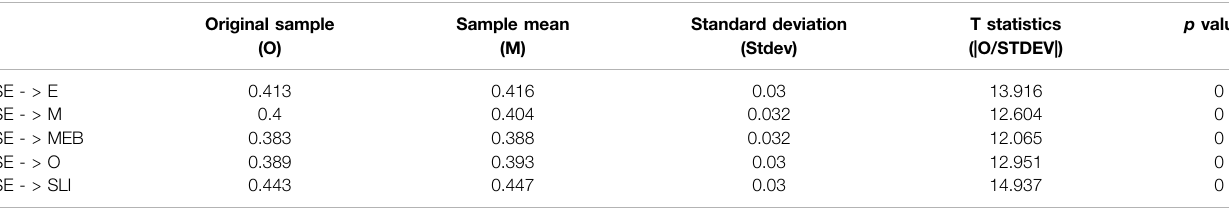
TABLE 4 | Path coef fi cients of SE and sub-components.